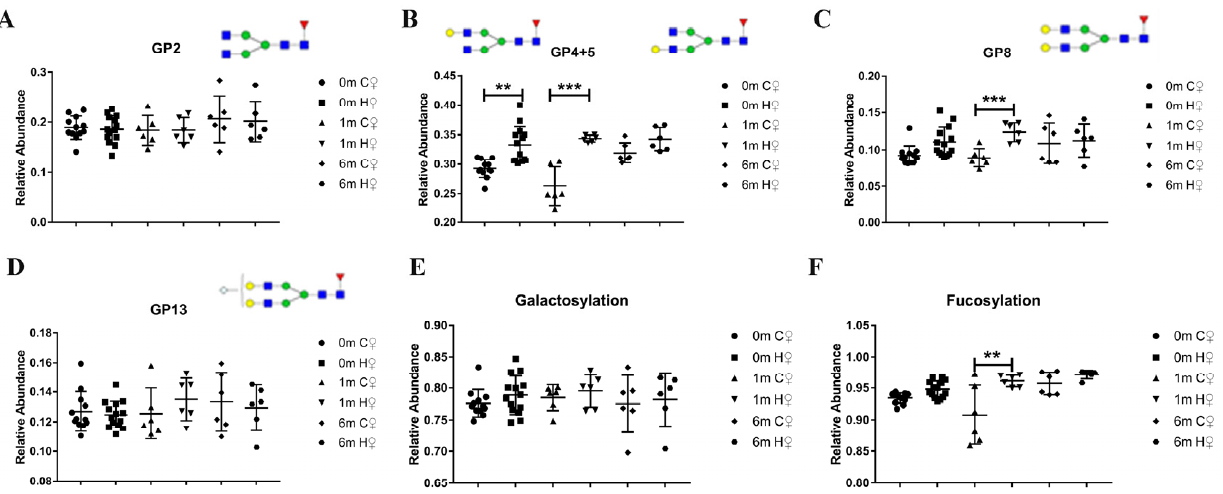
Figure 5. Female mice have a lower cancer incidence do not have the same stable IgG glycan changes as male mice, who have a higher high cancer incidence. ( A ) The relative abundance of GP2 in female mice does not change during the cancer induction process. ( B ) The sum of the relative abundances of GP4 and GP5 in female mice does not change regularly during the cancer induction process. ( C ) The relative abundance of GP8 in female mice only showed a decrease after the first month of the cancer induction process. ( D ) The relative abundance of GP13 in female mice did not change during the cancer induction process. ( E ) The relative abundance of galactosylation in female mice did not change during the cancer induction cases. ( F ) The relative abundance of fucosylation in female mice only showed a decrease one month after the initiation of the cancer induction process. Structural symbols are the same as Figure 2. Data are expressed as mean ± SD. * p < 0.05, ** p <0.01, *** p <0.001. (C—control WT group; H—HCC WT group; 0m/1m/6m —0 month/1 month/6 months after admin- istration; ♀ —female mice).